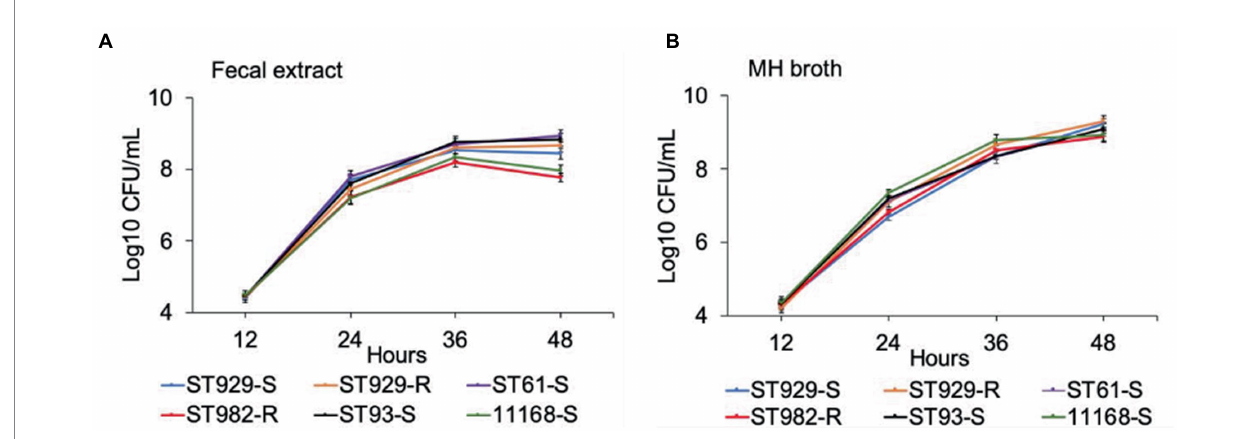
FIGURE 1 Growth kinetics of FQ-resistant and FQ-susceptible Campylobacter jejuni strains grown in bovine fecal extract (A) and MH broth (B) . FQ-resistant C. jejuni ST-982 and ST-929r are represented by the red and orange lines, respectively. FQ-susceptible C. jejuni ST-929s, ST-93, ST-61, and NCTC 11168 are represented by the blue, black, purple, and green lines, respectively. The number of the bacterial colonies was measured at 12, 24, 36, and 48 h of incubation. The experiment was repeated twice, and the results of one representative experiment are shown.